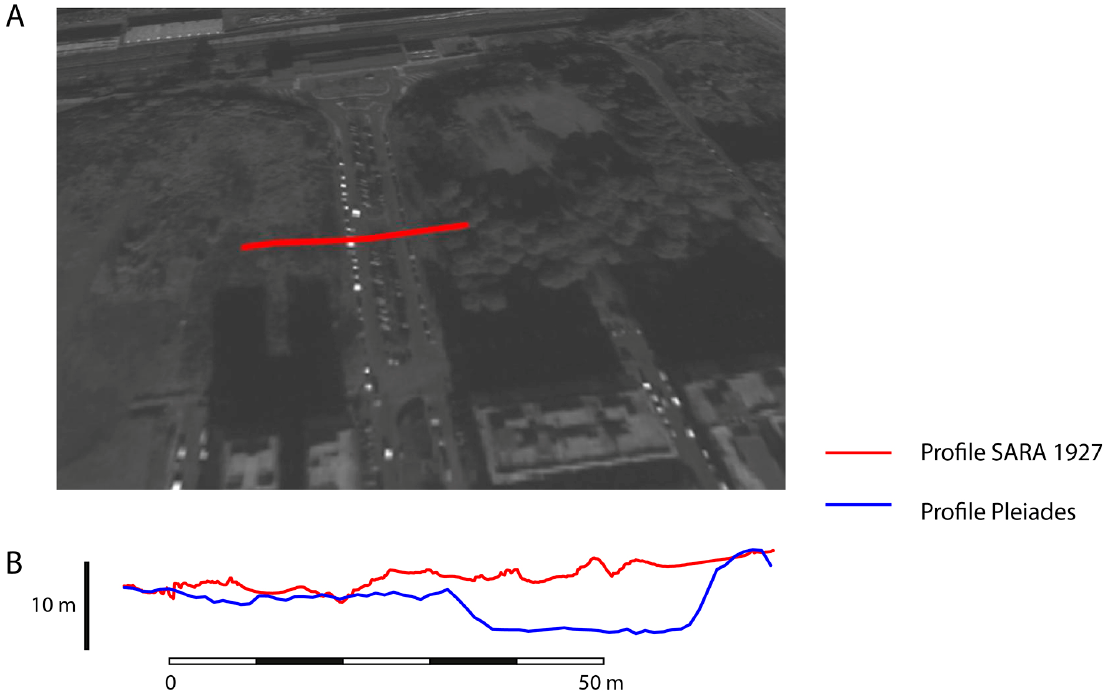
Figure 18. ( A ) 3D prospective view of the Pléiades-HR orthophoto on the DSM and of the profile (in red); ( B ) relative comparison of the profile shape extracted from the DSM SARA_1927 with the profile shape from DSM Pléiades—HR (stereopairs of January 2017).